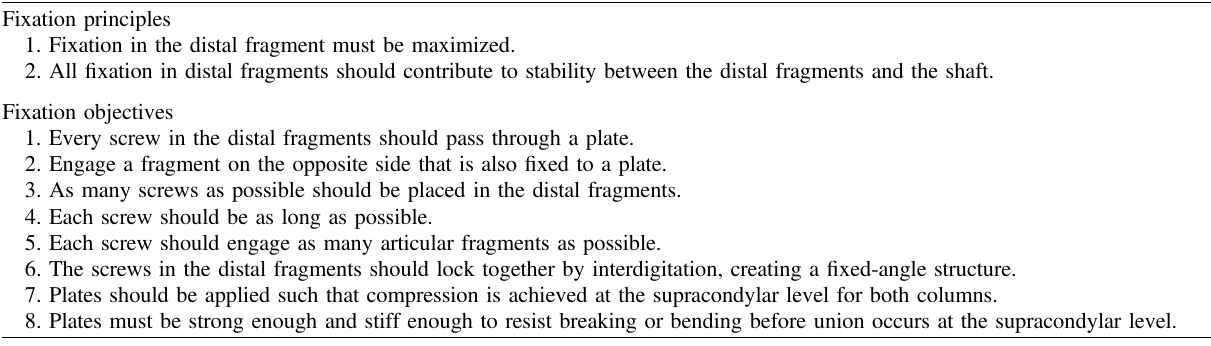
Table 4. Key attributes to successful fi xation (O ’ Driscoll [4]). Fixation principles